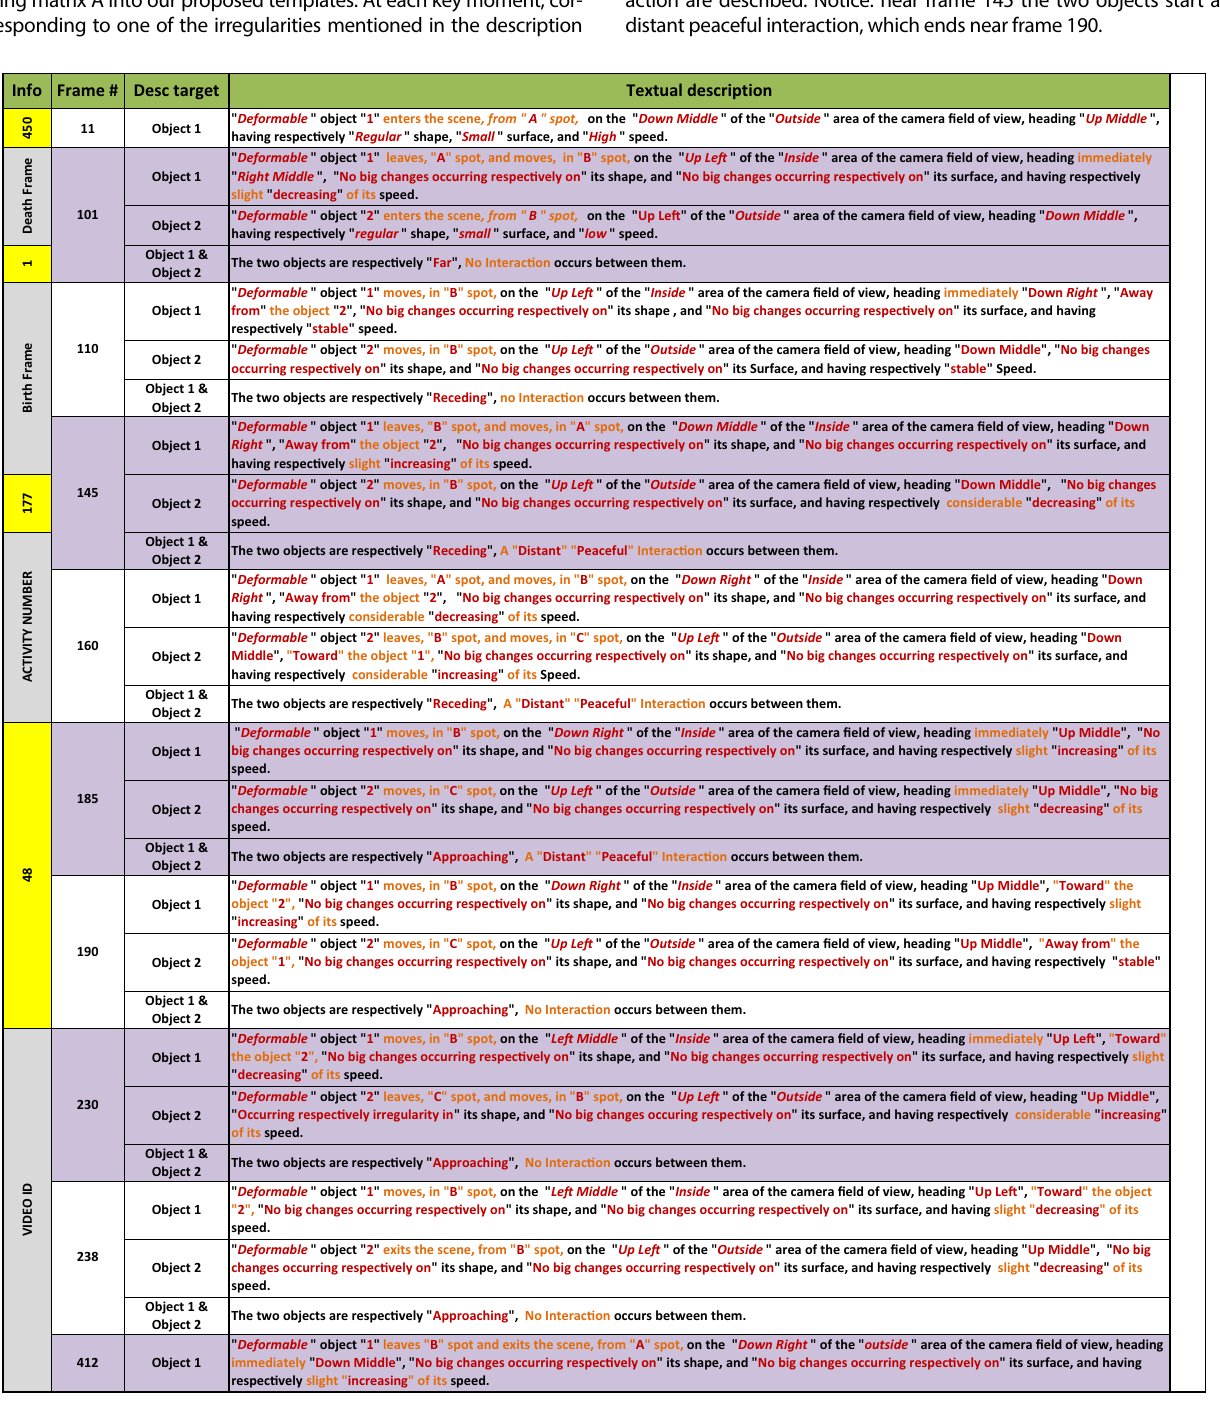
of Table 7 and marked in red, the full state of the objects and the inter- action are described. Notice: near frame 145 the two objects start a distant peaceful interaction, which ends near frame